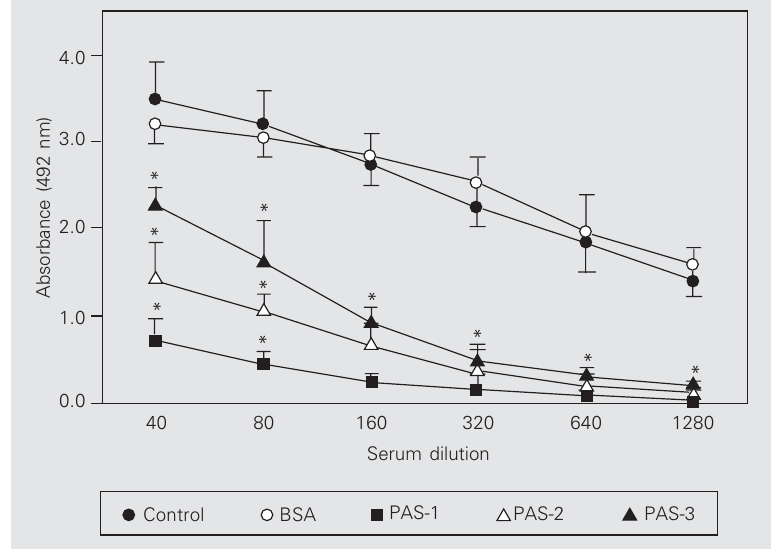
Figure 2. Effect of PAS-1, PAS-2 and PAS-3 on the humoral immune response. Groups of 5